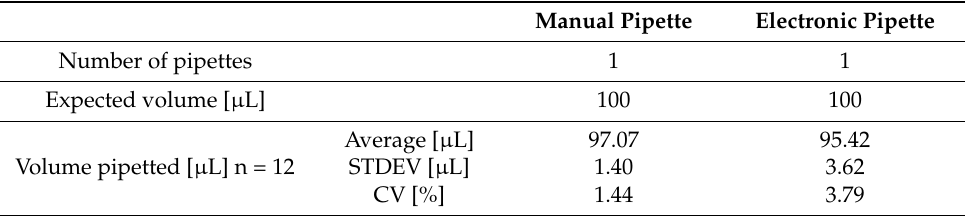
Table 7. Measurement results of pipetting 100 µ L using manual and electronic pipettes.